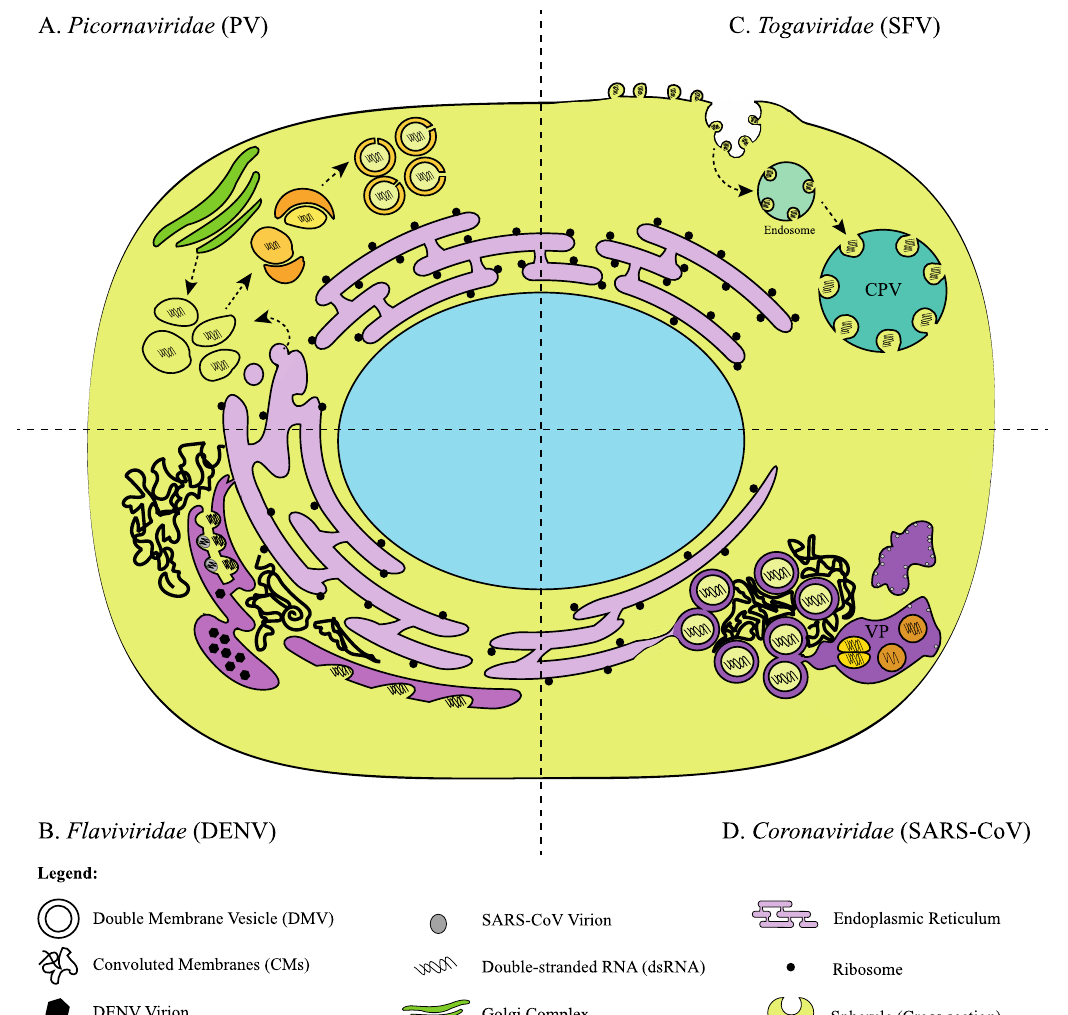
Figure 1. Biogenesis of Viral Replication Complexes (VRCs): Representative diagram of the structure and biogenesis of the VRCs for each family based on electron microscopy from the following references: Poliovirus (PV) [23] Semliki Forest virus (SFV) [24], Dengue virus (DENV) [15], Severe acute respiratory syndrome coronavirus (SARS-CoV) [25]. Diagram not to scale. ( A ) Formation of the PV VRC: Early in infection single membrane vesicles that contain dsRNA are derived from the ER and Golgi components. Progression of infection results in vesicles wrapping around each other inducing the formation of DMVs; ( B ) Formation of the DENV VRC: Spherule structures containing dsRNA form on modified rough-ER membranes surrounded by convoluted